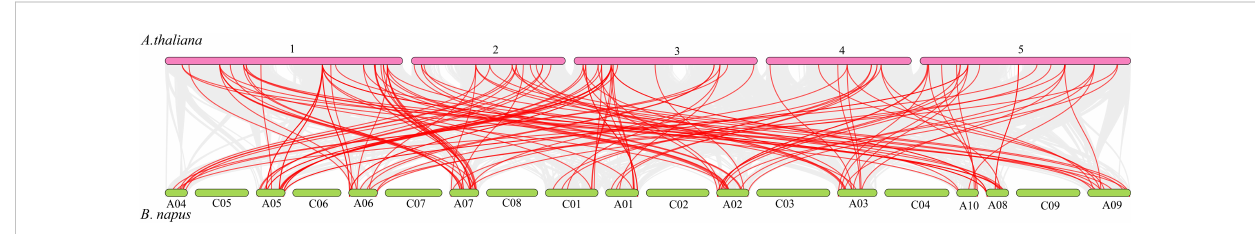
FIGURE 3 Synteny evaluation of AtGELP and BnGELP genes. The gray lines indicate all collinear blocks, and the red lines highlight the orthologous relationships between AtGELPs and BnGELPs